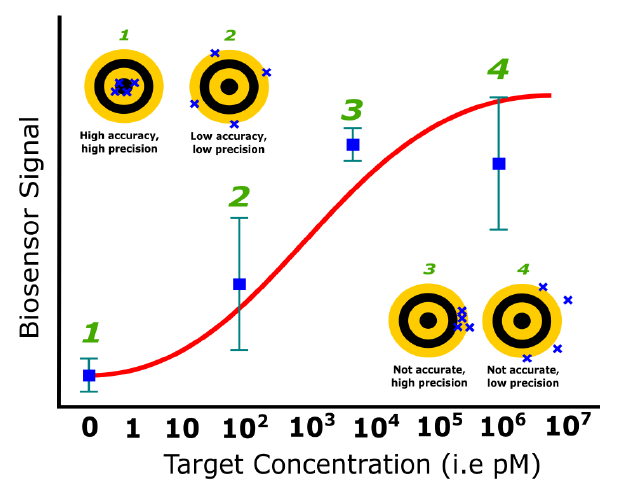
Figure 10. Illustration of the accuracy and precision concepts in the biosensor repeatability and its representation in the standard